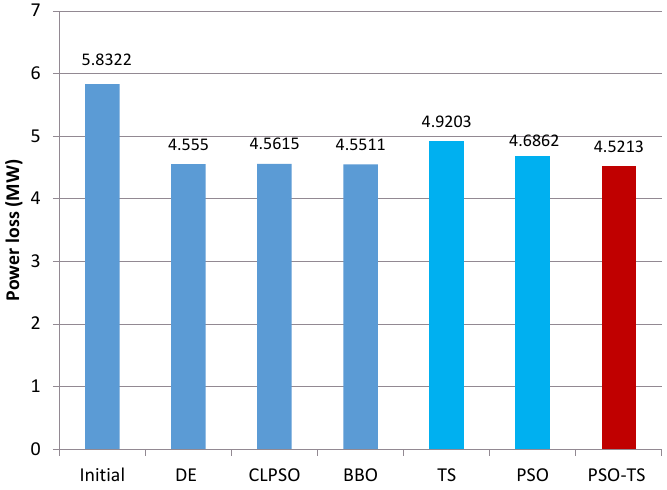
Figure 9. Comparative graph of the power losses (Case 2).